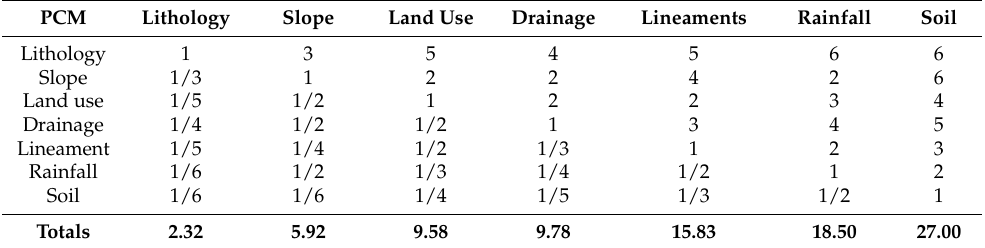
Table 5. Pairwise comparison matrix (PCM) for standardising factor scores.